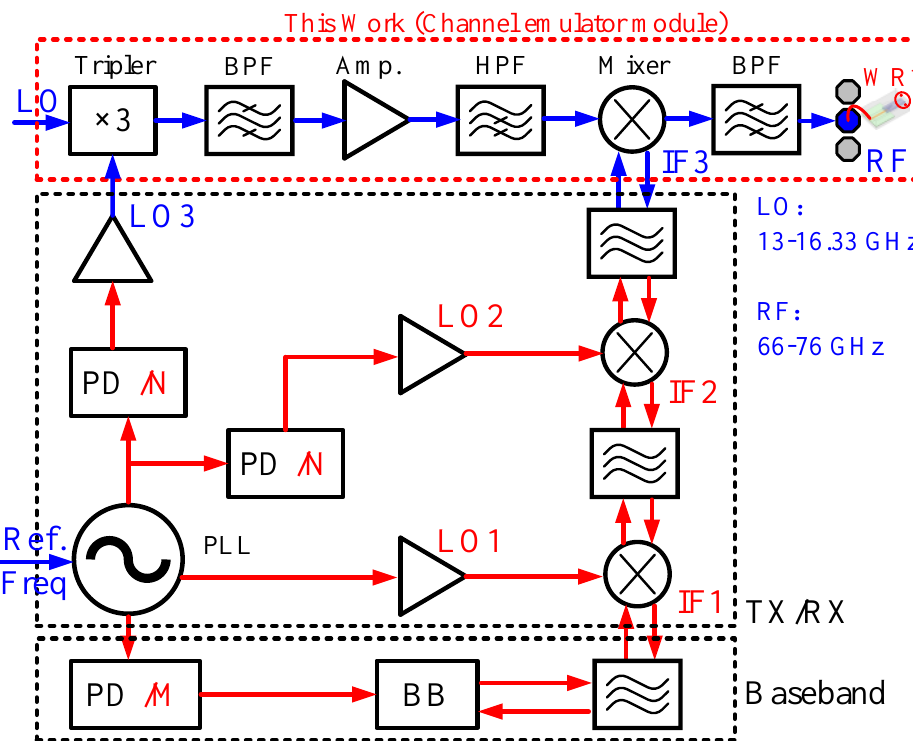
Figure 1. System block diagram of the channel emulator